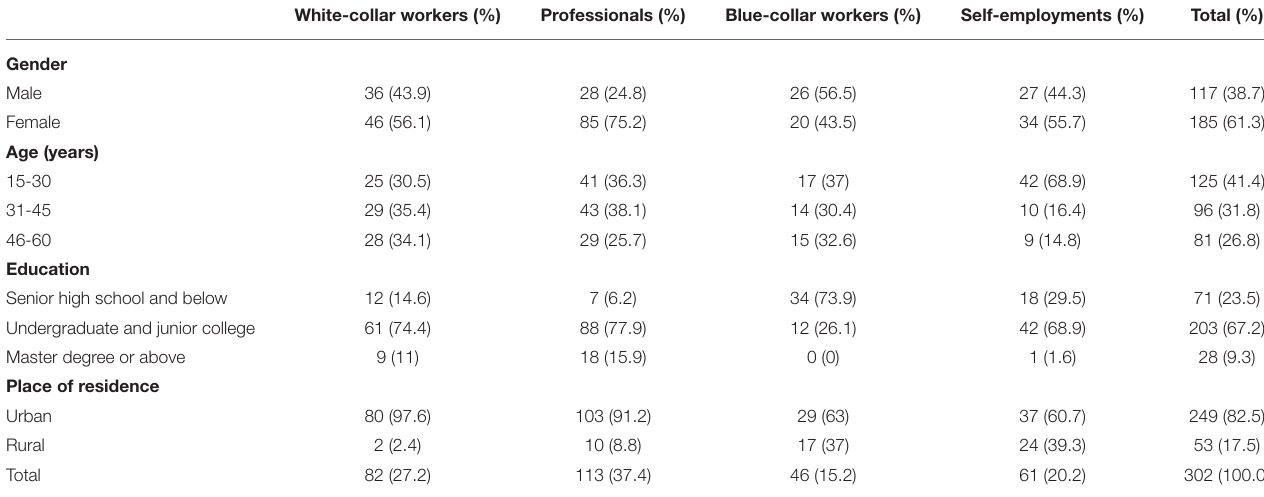
TABLE 1 | Demographic characteristics of respondents.